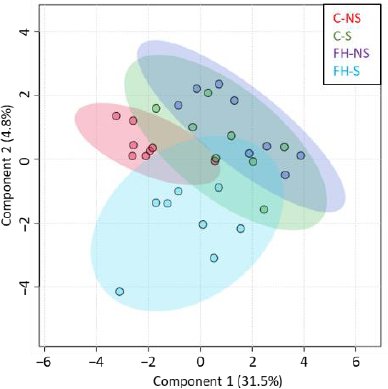
Figure 5. Proteins differentially expressed with the interaction Stress × Supplementation ( n = 205). Graphic representation defined by the first two components (1 and 2) of the sparse partial least squares discriminant analysis (sPLS-DA).